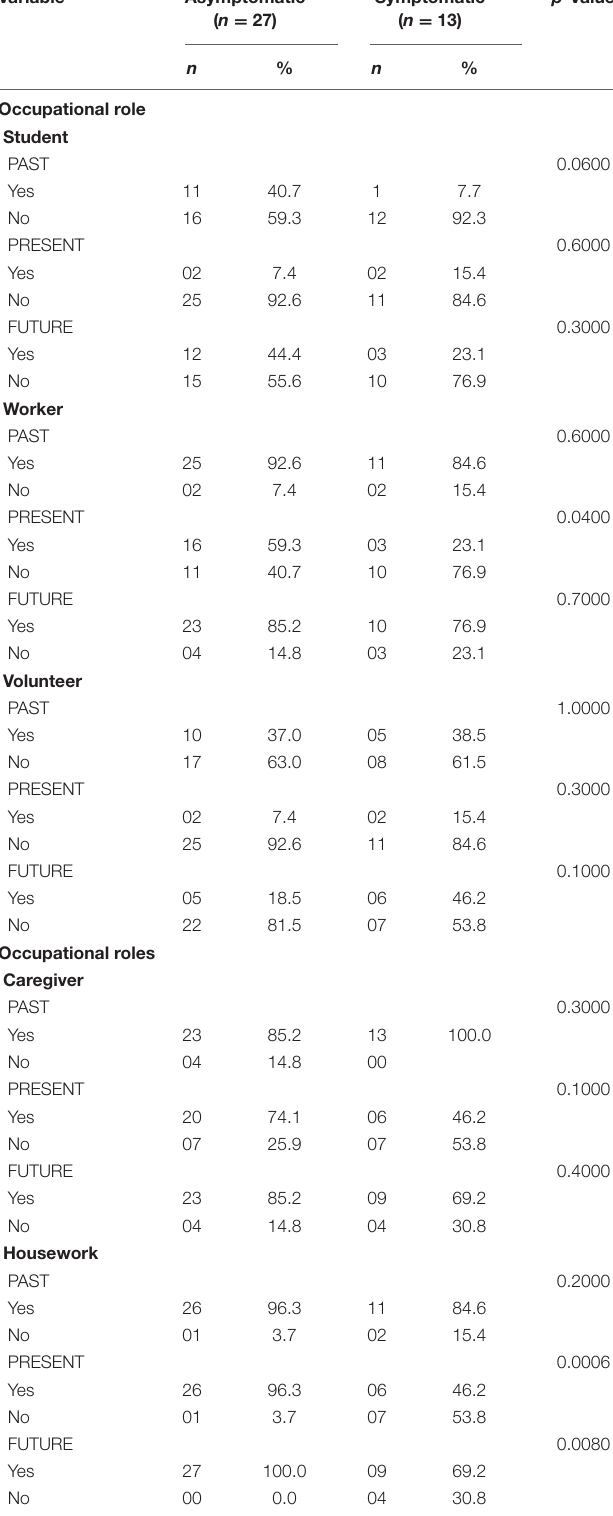
TABLE 4 | Distribution of patients based on the Occupational Roles Identification List score by group.